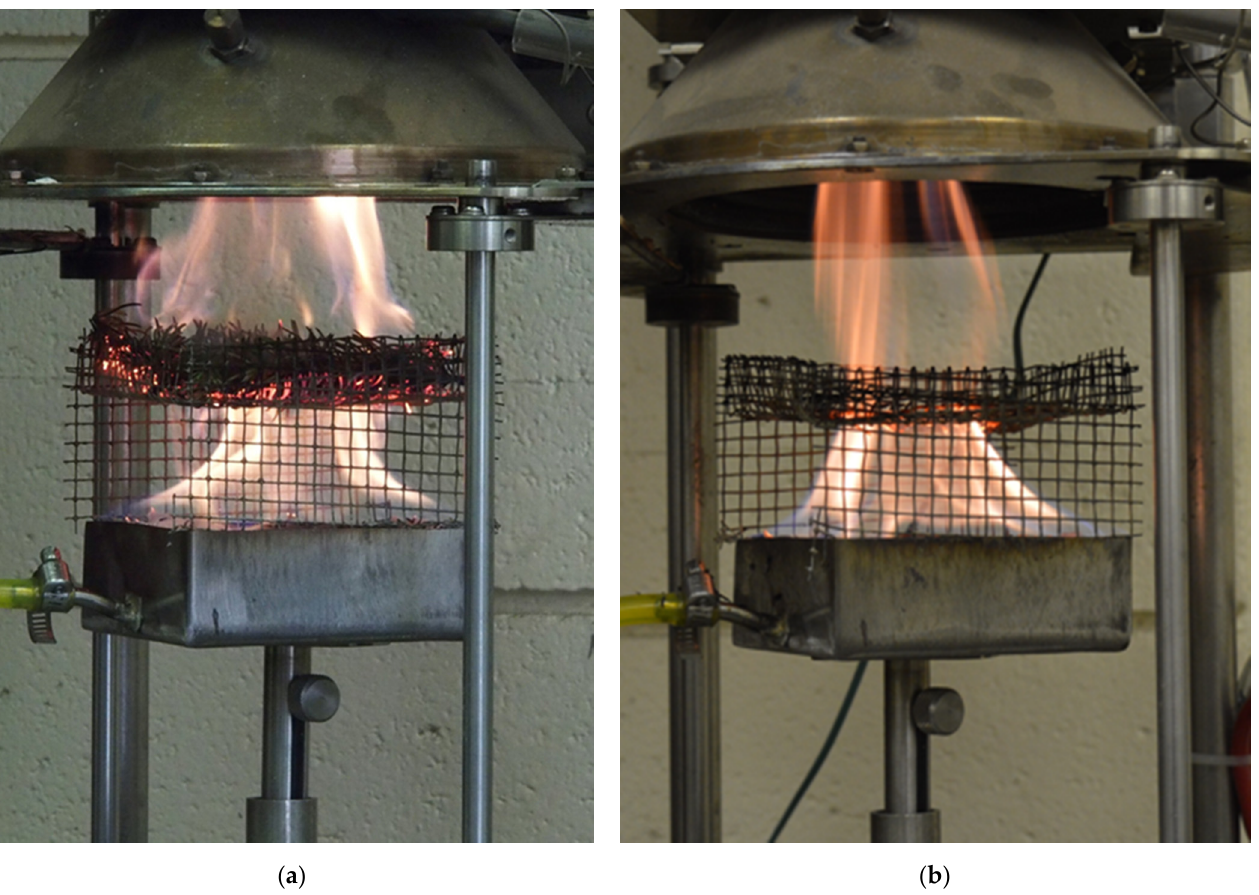
Figure 2. The proposed test set-up for measuring the energy release contribution of the sample to the incoming flame using an oxygen consumption cone calorimeter. The energy release of ( a ) the incoming methane flame interacting with live fuel was greater (even when only judged visually by the volume of flames), compared with ( b ) the energy release of the methane flame alone. This difference in energy release represents the fuel element’s/sample’s contribution to the energy release of the incoming methane flame ∆ e + (kJ) in Equation (1). From bottom to top in ( a ): load cell, a methane burner, incoming methane flame, wire-mesh sample holder containing a live fuel sample burning within incoming methane flame, and outgoing flame (methane flame mixed with the flame of the burning live fuel sample). Vertical (upward) direction of flame propagation represented by the experimental setup of the apparatus is slightly different from that occurring in real crown fire flame-fronts, where it is forward-upward.